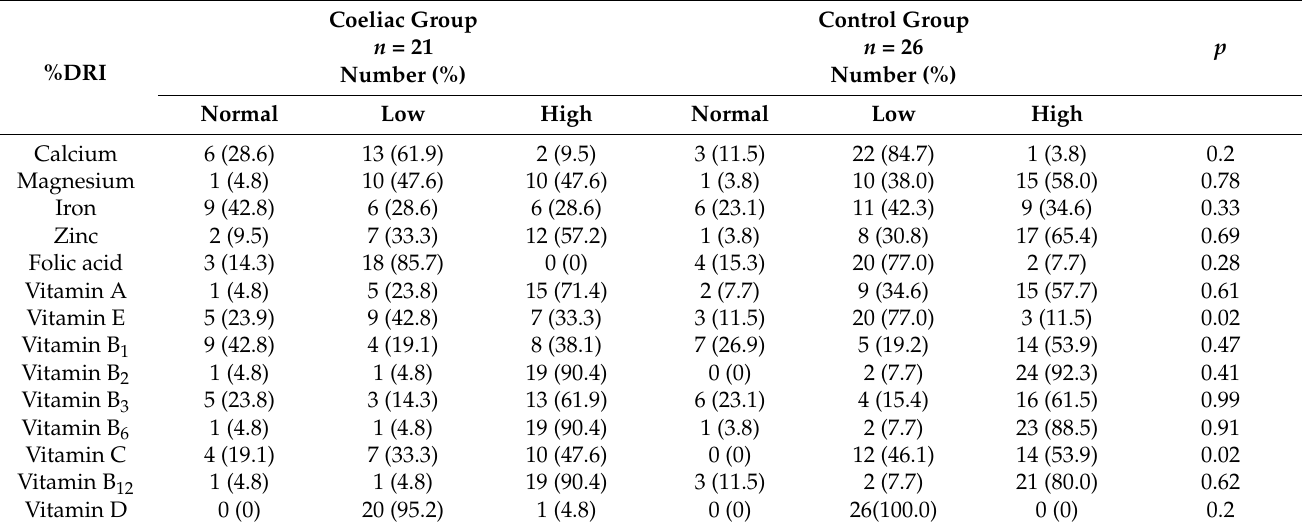
Table 10. Number of children with normal, low and high dietary reference intake (%DRI) for micronutrients in coeliac and control subjects.